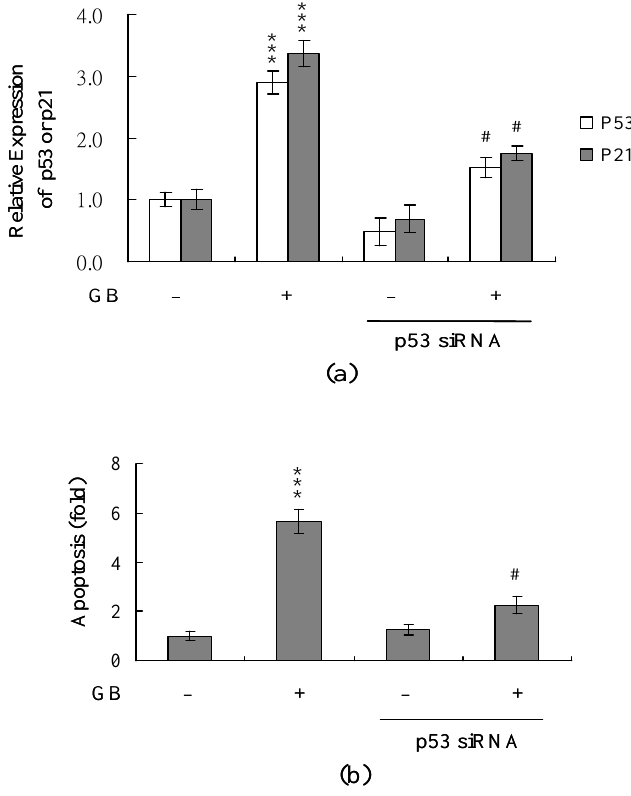
Figure 7. Knockdown of p53 can protect MCF-7 cells against ginkgolide B-induced apoptosis. Cells were transfected with siRNA targeting p53, incubated for 24 h, and then treated with ginkgolide B (80 µ M) for another 24 h. (A) The mRNA expression levels of p53 (A) and p21 (B) were analyzed using real-time PCR. (B) Cell apoptosis was measured as described in Figure 1. *** P <0.001 versus the untreated control group. # P <0.001 versus the ginkgolide B-treated only